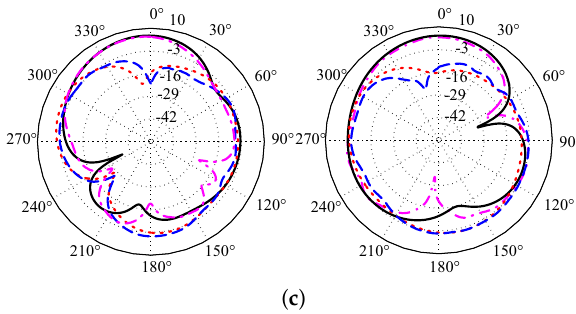
Figure 9. Simulated and measured radiation patterns of the proposed antenna: ( a ) 3.5 GHz; ( b ) 4.25 GHz; and ( c ) 5 GHz. RHCP: Right-handed circular polarization.